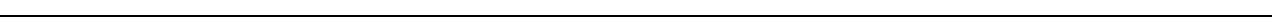
Fig. 4 Molecular model of fl ow-induced VWF activation. a Schematic of extended VWF 5 and platelet surface drawn to scale, including average spacing between GPIb α /GPIb β 1:2 complexes and length of mucin-like regions shown as brush-like curves. “ + ” and “ − ” indicate net electrostatic charge at plasma pH; sialic acid makes mucins negatively charged. b Model of VWF activation under fl ow. VWF is tethered on a vessel wall. Three values of shear stress ( σ ) are shown that do not extend, extend but do not activate, or extend VWF and are above the threshold shear stress required for activation ( σ 50 , a function of N VWF ). Tension is proportional to the number of VWF monomers downstream of the tether point. Activation of A1 is schematized as disruption by mechanical tension of hydrogen bonds involving residues external to the A1 disul fi de, converting A1 from a low-af fi nity square shape to a high-af fi nity round shape. c , d Views of the GPIb α – A1 complex crystal structure 55 with similar orientations in the upper portion of each panel. c Ribbon cartoons of GPIb α in gray and A1 in rainbow from N ( blue ) to C-terminus ( red ). Spheres mark N and C-termini. The lower panel shows the force-bearing region at the N and C-termini near the long-range disul fi de ( gold stick ). Hydrogen bonds involving residues external to the disul fi de are shown as black dashes . d Electrostatic surface potentials colored according to the key. In the lower, open-book view, GPIb α and A1 are rotated 90° towards the viewer around the dashed axis to show their highly electrostatic interfaces. e Shear and elongational fl ows 5 . ( Left ) Shear fl ow can be represented as the combination of elongational fl ow and rotational fl ow. Arrows show fl ow streamlines and dots indicate no- fl ow regions. ( Right ) Effects of vasoconstriction and bleeding on fl ow. VWF concatemers ( red ) are more compact in shear fl ow, and as the elongational component of fl ow increases, they are more extended. When tethered to the vessel wall, as shown in the constriction site, VWF is more easily extended when tethered than when in free solution since tension exerted on it cannot be minimized by movement with the fl ow — rather, the tension in the molecule must resist the total drag force induced by the fl ow on